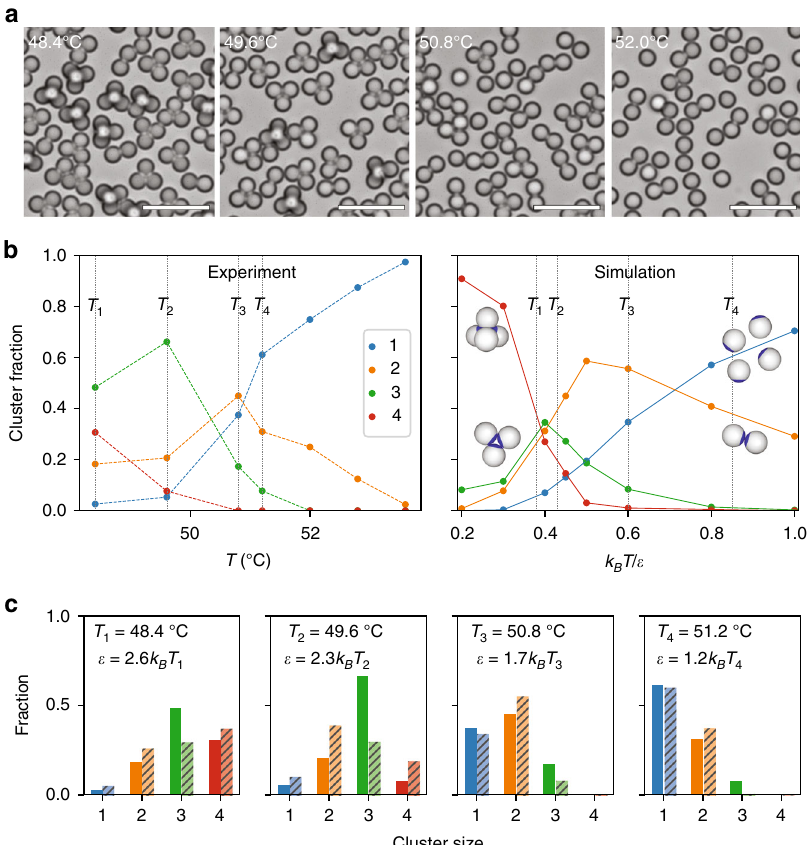
Fig. 2 Assembly of Janus particles with patch ratio of χ = 0.13. a Bright- fi eld images show self-assembled clusters of Janus particles at various temperatures. Particles disassemble at high temperature and self-assemble at low temperature at the DNA-coated surfaces, forming singlets and clusters of dimers, trimers, and tetramers. Scale bar = 10 μ m. b Distribution of singlets and clusters of 2, 3, and 4 particles at different temperatures from experiment (left) and computer simulation (right). Singlets and dimers are dominant at high temperature while trimers and tetramers are dominant at low temperature. c Cluster fractions as a function of temperature from experiment (solid color bars) and computer simulation (hashed). The depth ε of the attractive effective potential due to DNA binding, indicated in each panel, is determined by choosing the values of k B T / ε in the simulations that best match the experimental distributions of cluster fractions for the different temperatures indicated in ( b ). Low temperature favors the formation of larger clusters, which are limited by geometry to four particles for the patch ratio χ = 0.13 shown